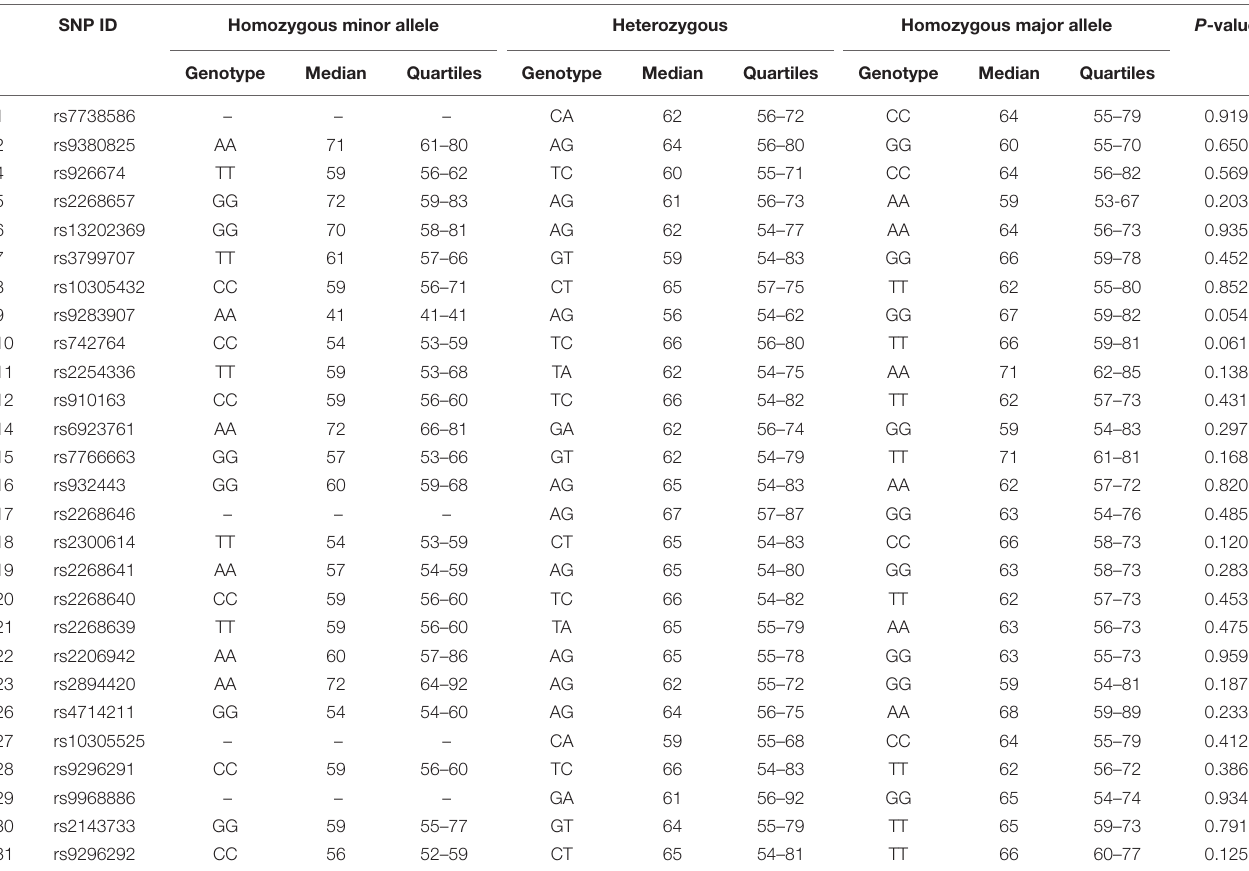
results according to 2